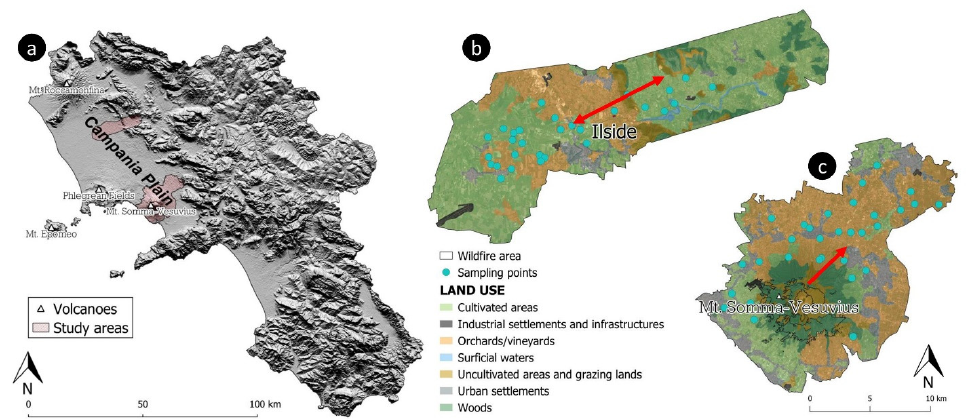
Figure 1. ( a ) DTM of Campania region, with the indication of the study areas; ( b ) soil sampling map at the Ilside site; ( c ) soil sampling map of Mt. Somma-Vesuvius slopes. Red arrows on maps represent the main wind directions during the fire events.